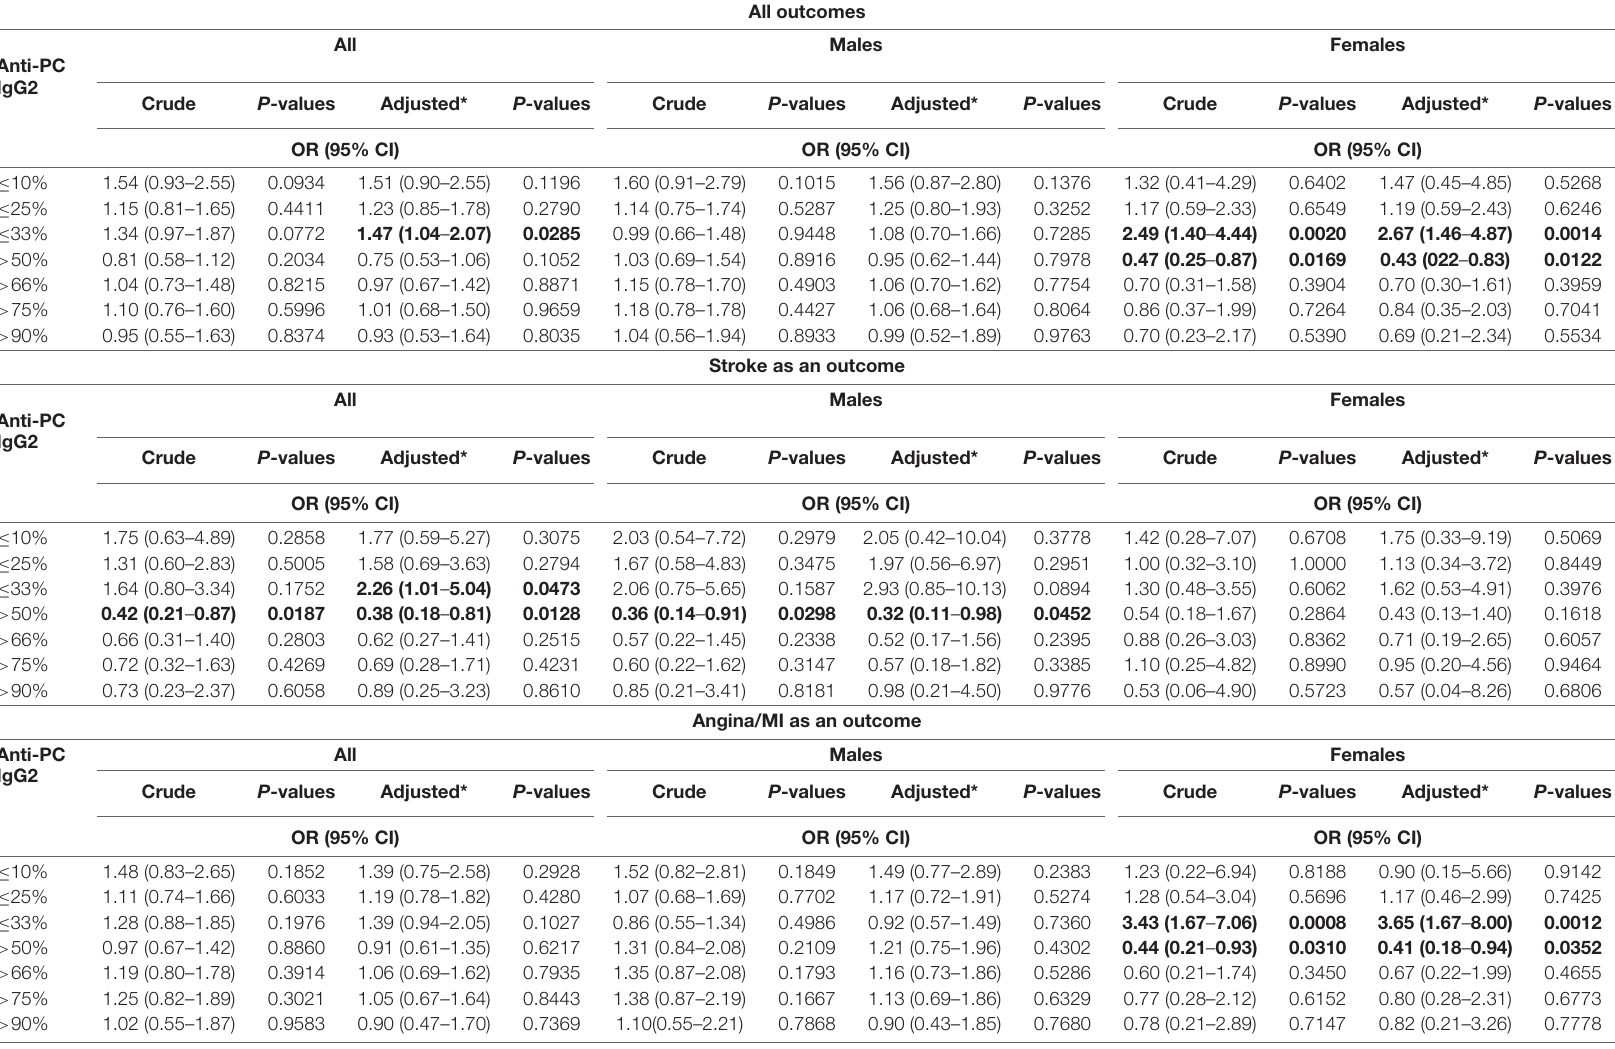
TABLE 4 | Association between levels of IgG2 anti-PC and risk for CVD, stroke, and MI among all participants and men and